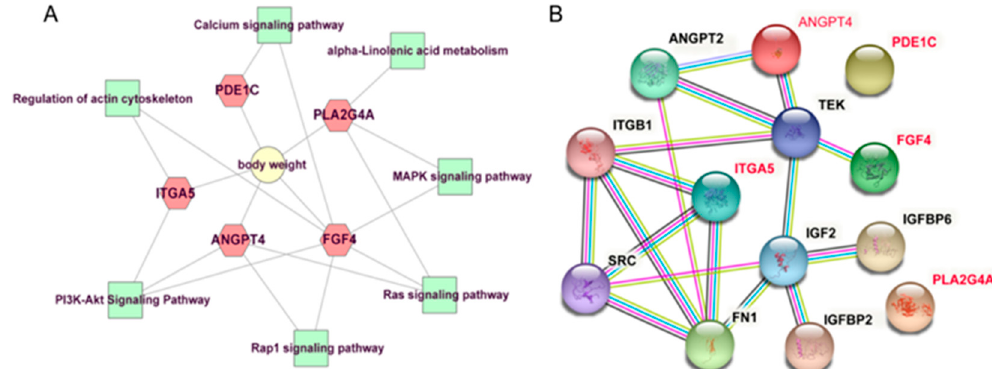
Figure 5. A represents the network diagram of the candidate genes affecting BW and their belonged pathways; B represents the PPI network of the candidate genes affecting BW. The genes marked in red represent potential candidate genes influencing BW in this study.